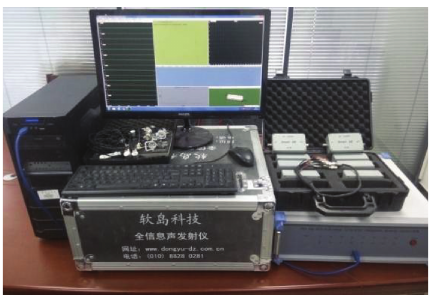
Figure 3: AE data acquisition